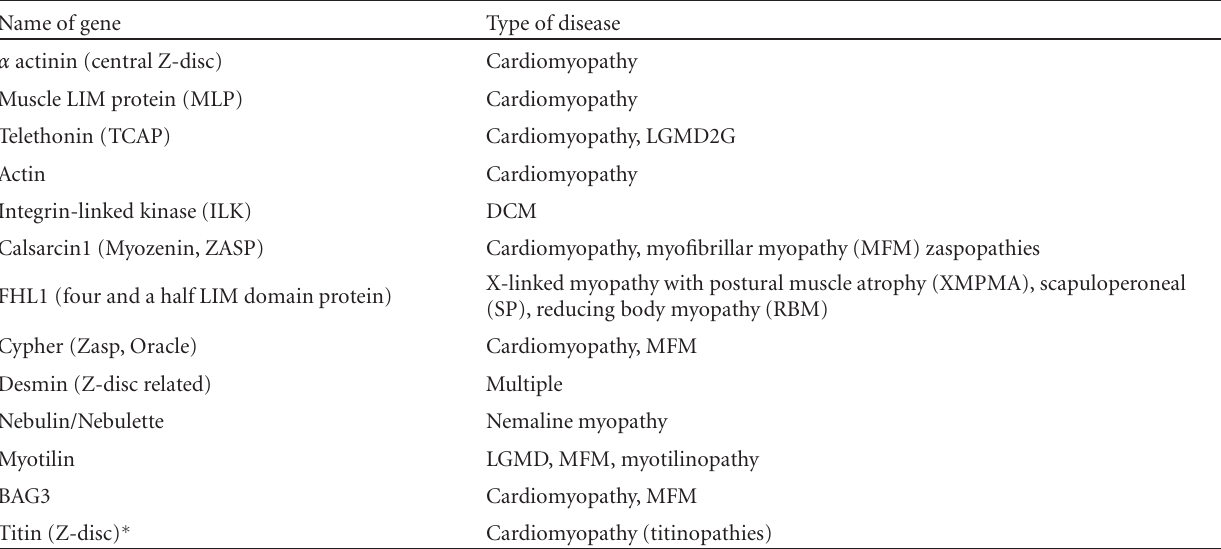
Table 1: Z-disc proteins involved in human disease.